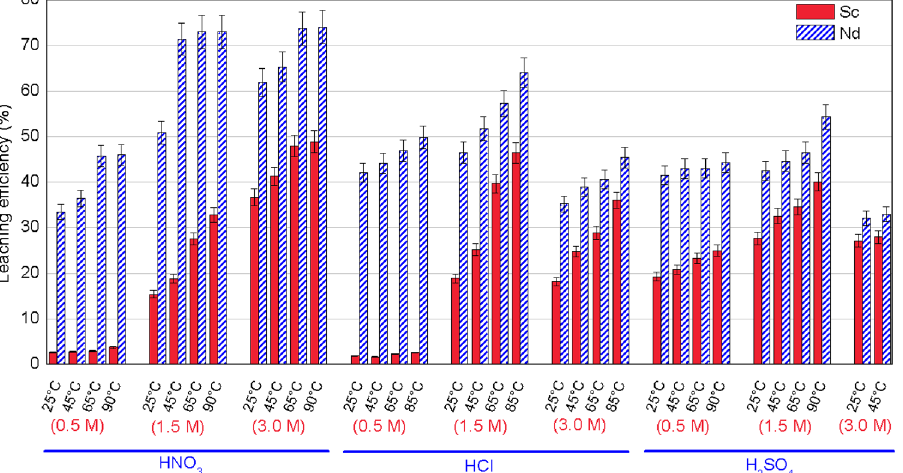
Figure 2. Leaching efficiency of neodymium (Nd) and scandium (Sc) using HNO 3 , HCl, and H 2 SO 4 at different temperatures (25–90 °C) and concentrations (0.5, 1.5, 3.0 M) within 30 min residence time. Error bars represent the standard error of the mean for four replicates.